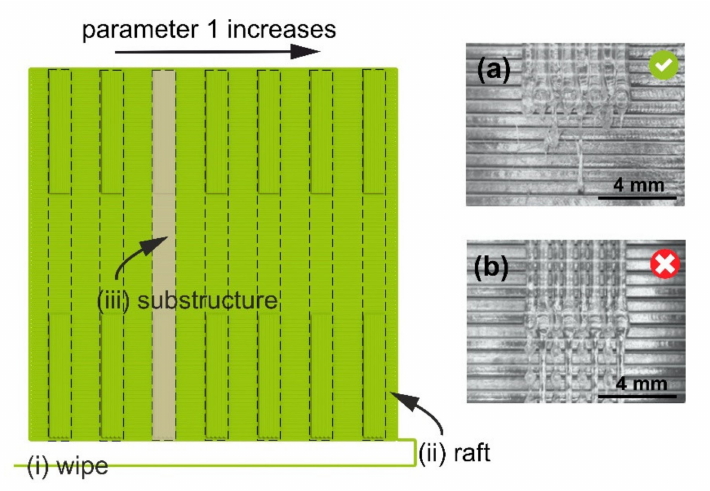
Figure 3. Test geometry for the retraction distance test (#10) consists of (top view) (i) a wipe strip, (ii) a square raft structure to support (substructures), and (iii) seven test substructures. The values of the retraction distance (Parameter 1) increase from left to right. The insets show micrographs of two substructures in a test for PA: ( a ) and ( b ) correspond to an optimal (4.00 mm) and not optimal (1.00 mm) value of the retraction distance, respectively. Other PP values: bead height, 0.20 mm; extrusion temperature, 268 ◦ C; printing speed, 25 mm / s; retraction speed, 120 mm / s; nominal bead width, 0.80